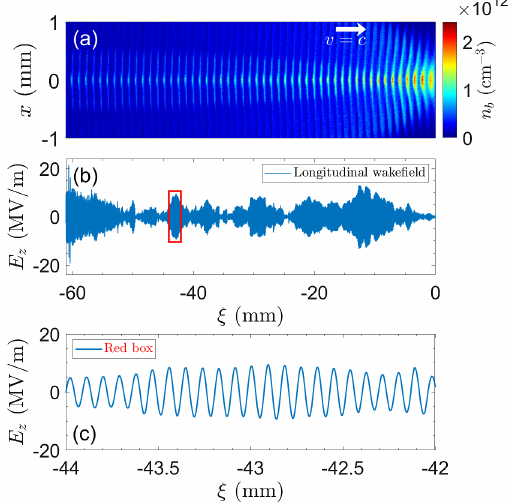
FIG. 3. Self-modulated proton bunches (a) and longitudinal wakefield (b) inside the APL plasma column with a density of 1 . 4583 × 10 17 = cm 3 . The propagation direction of the bunches is to the right. Subfigure (c) is the longitudinal wakefield inside the red box indicated in (b). The longitudinal coordinate ξ ¼ z − ct .